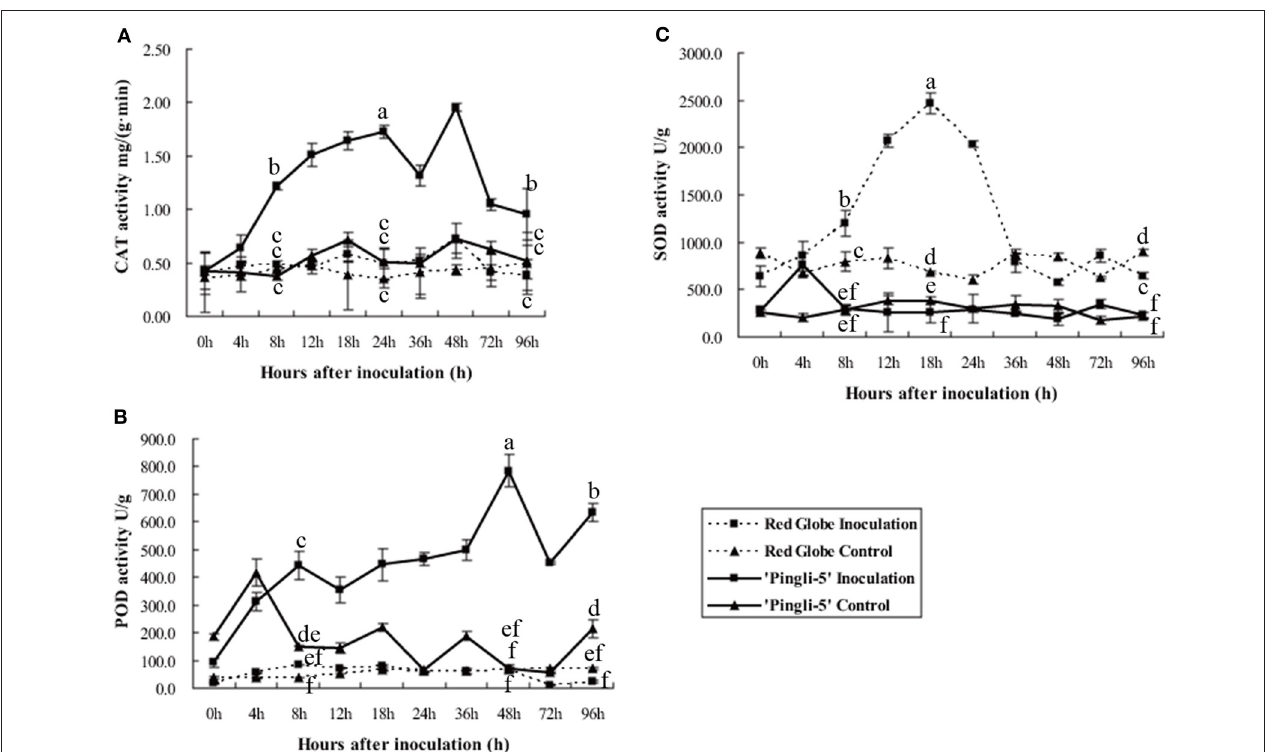
FIGURE 7 | Activities of catalase (CAT; A), superoxide dismutase (SOD; B) and peroxidases (POD; C) in proteins extracts from “Red Globe” and “Pingli-5” leaves 4, 8, 12, 18, 24, 36, 48, 72, and 96h post-inoculation (hpi) with B. cinerea and sterile water as the control. The means and standard deviations of three independent experiments are shown. Comparisons of statistical significance were made for the three indices. Different small alphabetical letters indicate statistically significant differences between different interactions of “Red Globe” and “Pingli-5” with B. cinerea at the indicated time points (Duncan’s multiple range test; P < 0.05